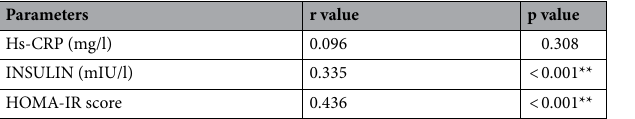
Table 4. Correlation of percentage expression of CD62P with hs-CRP, insulin and HOMA- IR score. Data represented as Spearman’s rho Correlation co-efficient ‘r’ with p-value. *p value significant at level of 0.05. **p value significant at level of 0.01.